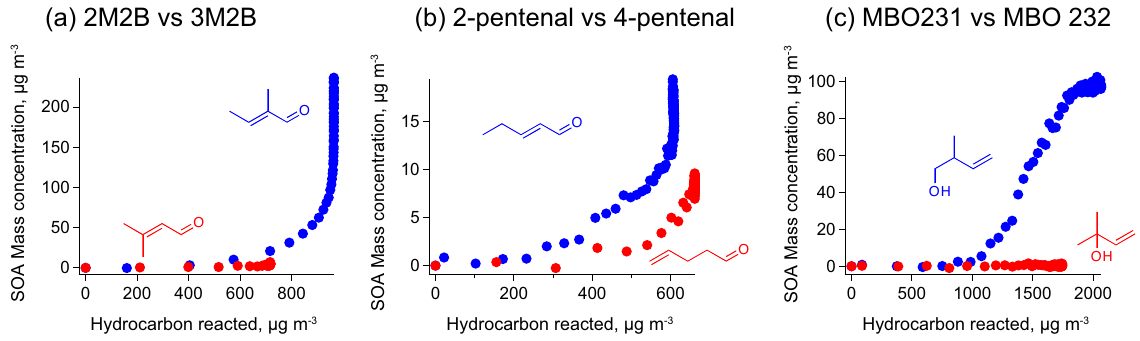
Fig. 6. Comparisons of time-dependent SOA growth from photooxidation of (a) 2M2B and 3M2B, (b) 2-pentenal and 4-pentenal, and (c) MBO232 and MBO 231 under high-NO 2 conditions. Within each plot, initial concentrations of parent hydrocarbons are comparable (see Table 2).